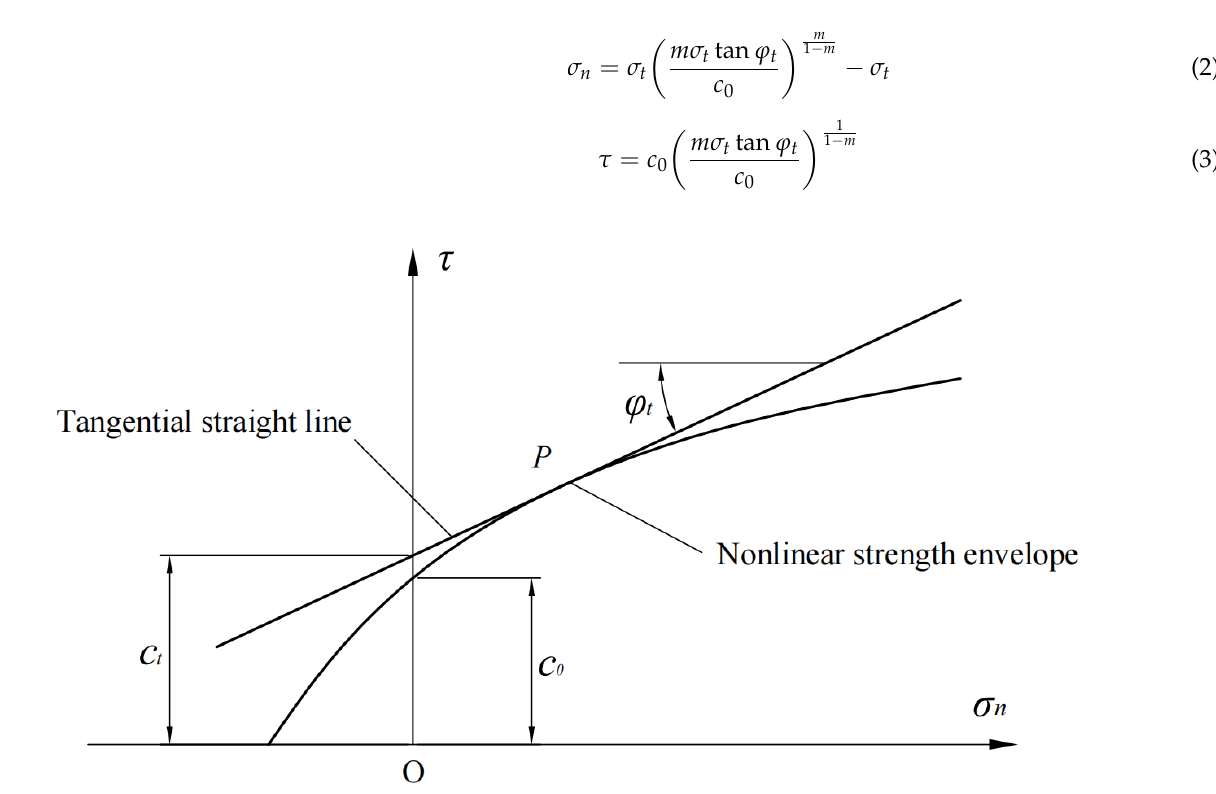
Figure 1. Nonlinear strength envelope and corresponding tangential straight line .